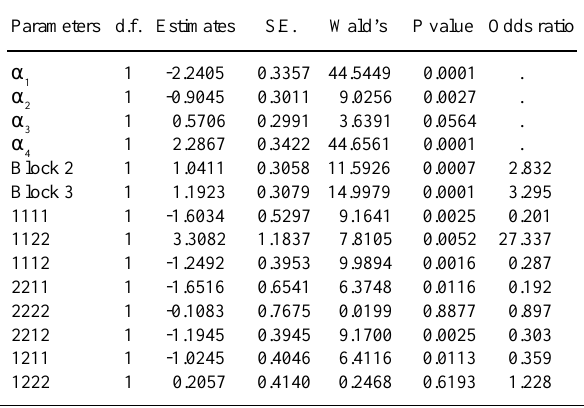
Table IV - Maximum likelihood estimates. Parameters d.f.